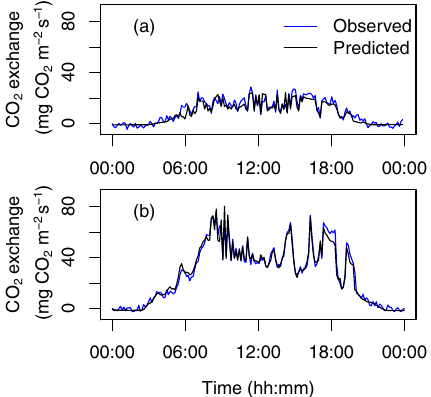
Figure 2. Measured and predicted leaf CO 2 exchange during 2 days: (a) early in the spring (8 May) and (b) in midsummer (18 July) in Finnish Lapland, 68 ◦